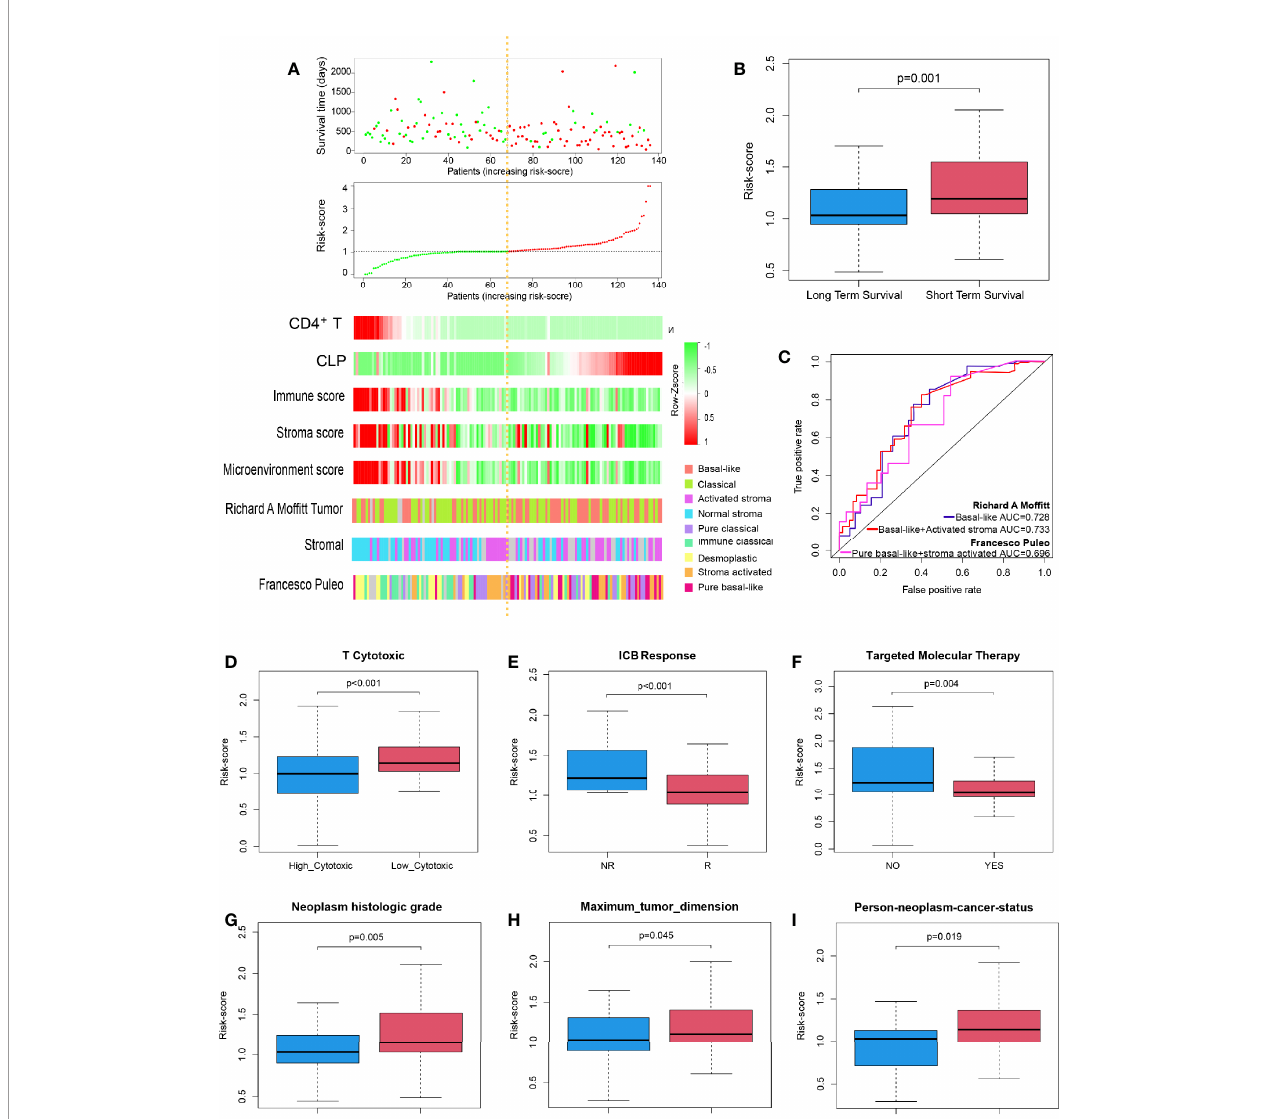
FIGURE 2 | Performance of the risk-score to identify PDAC molecular subtypes with poor prognosis and immunotherapy sensitivity in TCGA discovery cohort. (A) Dot plot of survival. Vertical and horizontal axes respectively represent survival time and OS samples, ranked by increasing risk-score. Red and green colors represent dead and living OS cases, respectively. The second fi gure from the top is a dot plot of risk-score. Vertical and horizontal axes respectively represent risk- score and OS samples, ranked by increasing risk-score. Red and green colors represent high and low risk cases, respectively. The remaining fi gure is a heatmap for the level of CD4 + T N , CLP in fi ltration, Immune Score, Stroma Score, Microenvironment score, and Mof fi t ’ s and Puleo ’ s molecular subtypes, ranked by increasing risk- score. (B) Box plot to depict risk-score between long-term survival and short-term survival. (C) ROC curves to depict the accuracy of risk-score in identifying PDAC molecular subtypes with poor prognosis in TCGA discovery cohort. (D – I) Box plot depicts risk-score of high T-cell cytotoxicity vs . low T-cell cytotoxicity, ICB no response vs . ICB response, no apply targeted molecular therapy vs . apply targeted molecular therapy, neoplasm histologic grade G1 – G2 vs . G3 – G4, tumor dimension ≤ 3.5 vs . > 3.5 cm, and person neoplasm cancer statue tumor free vs . with tumor, respectively. ICB, immune-checkpoint blockade; NR, no response; R, response; PDAC, pancreatic ductal adenocarcinoma; TCGA, The Cancer Genome Atlas; OS, overall survival; CLP, common lymphoid progenitor; ROC, receiver operating